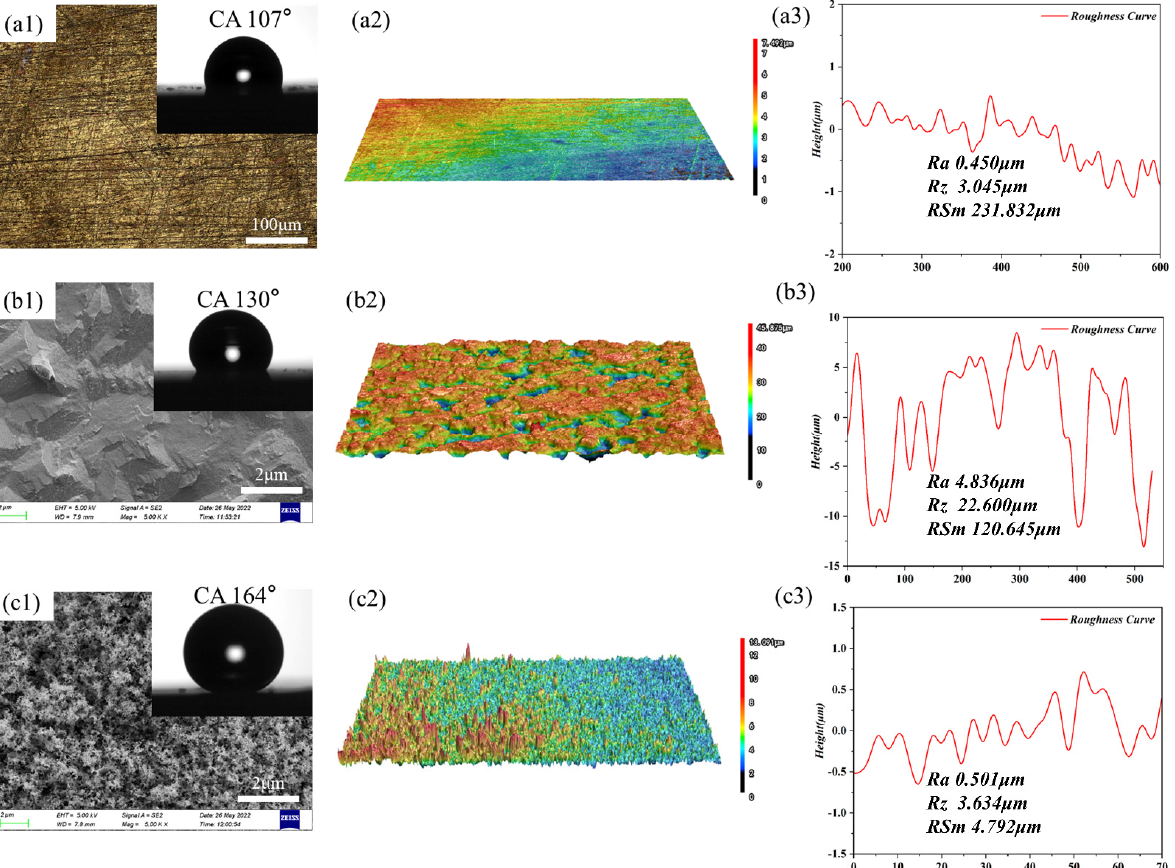
Figure 2. Surface morphology, contact angles, and surface roughness of samples. The first column shows the surface morphology of BS, ES, and SC, respectively; the second column shows the surface roughness of corresponding samples. The insets in the first column show the surface contact angles of each sample. The third column shows the results of the analysis of the surface roughness of the samples respectively .